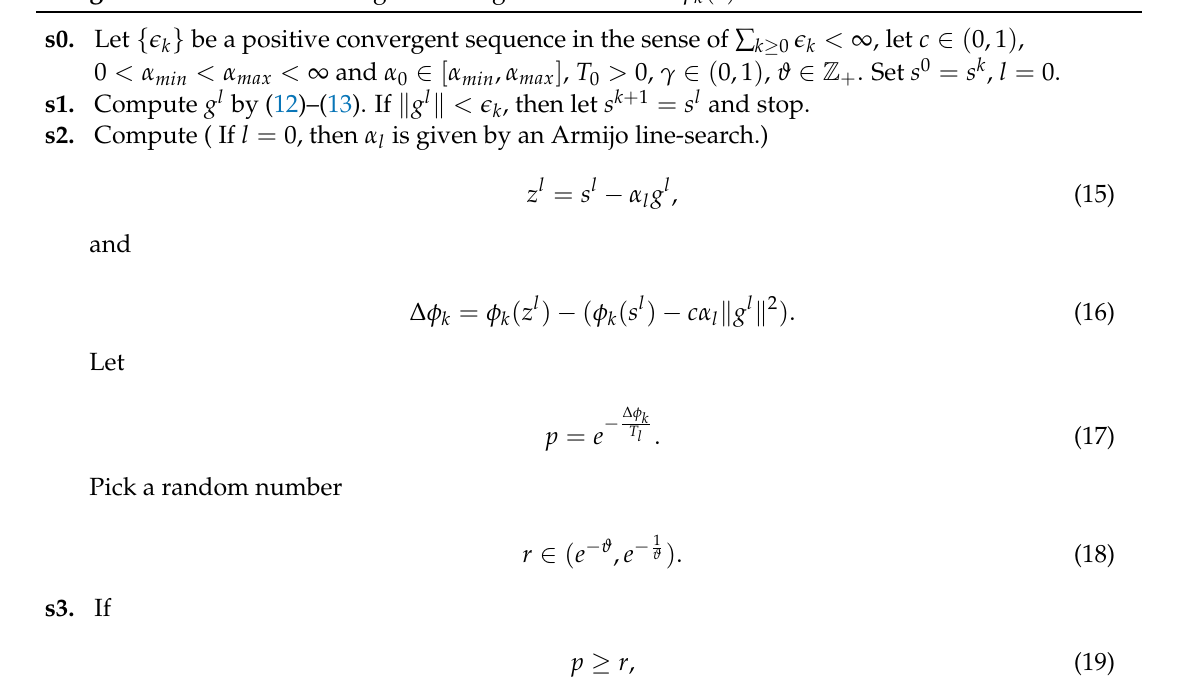
Algorithm 1: The SABB-Subgradient algorithm for min φ k ( s )